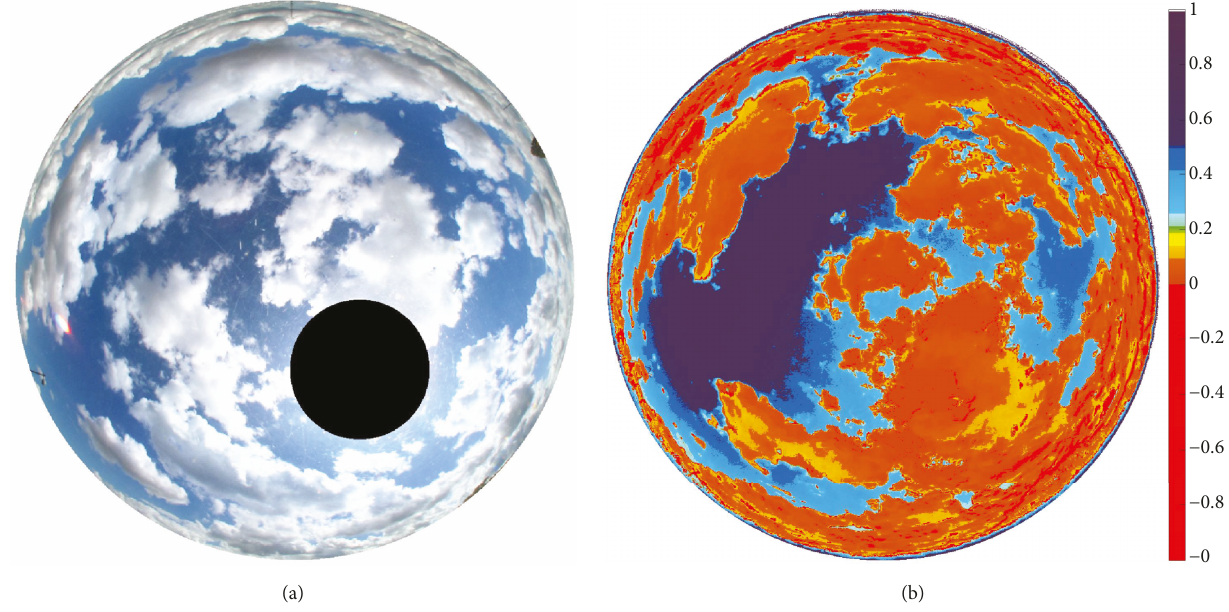
Figure 2: (a) Cropped black area and coverage of the sun from the original picture. (b) Haze Index image. Table 1: The neural network structure occupied in this